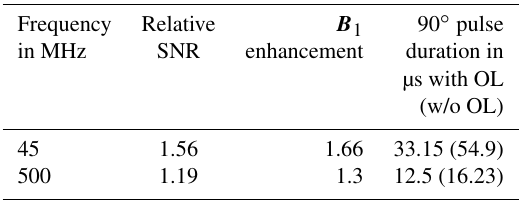
Table 3. Values calculated from the nutation spectra of water at Larmor frequencies of 45 and 500MHz, respectively. The values represent the ratio of the SNR, B 1 enhancement, and the pulse du- ration to produce the 90 ◦ flip angle. The comparison was made with and without the